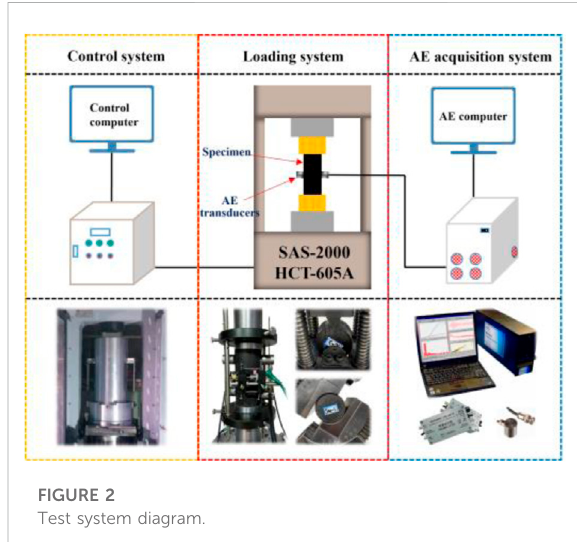
FIGURE 2 Test system diagram.